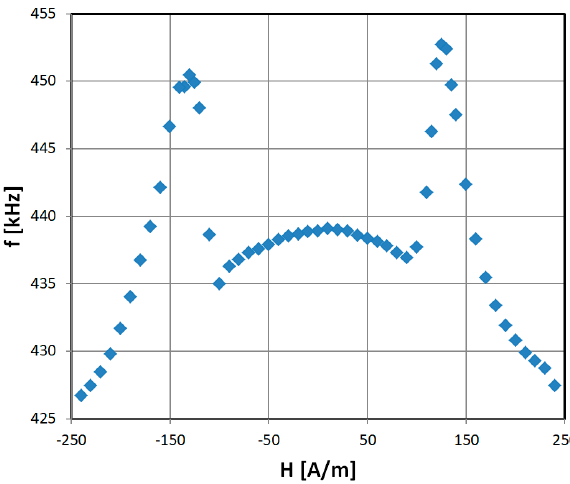
Figure 11. Exemplary results of GMI sensor with 555 transducer ‘batman’ output characteristic.